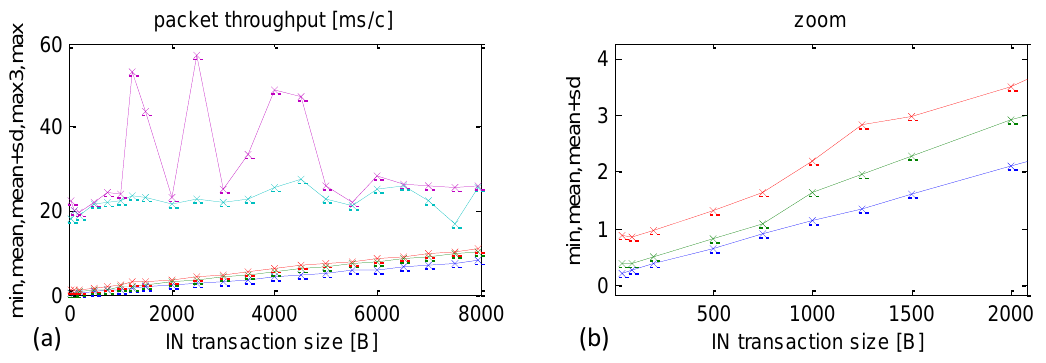
Figure 9. Experimental results of CCLT depending on packet size. ( a ) min, mean, mean + SD, max3, max of CCLT. ( b ) Enlargement of low time range.